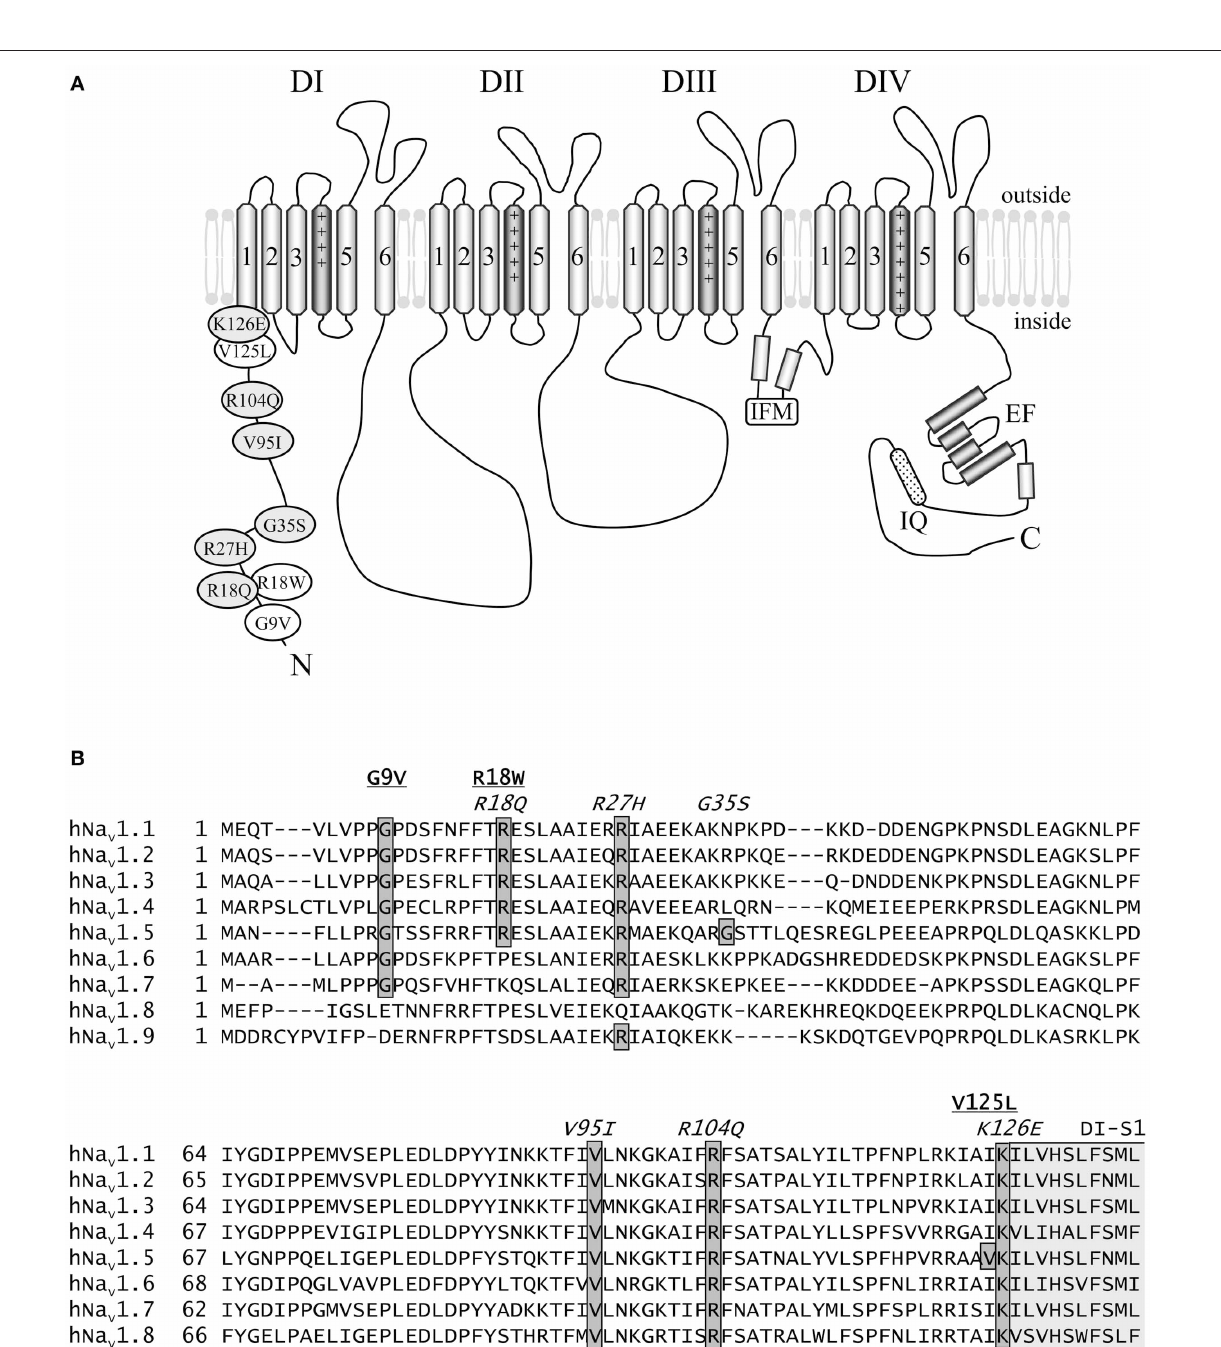
the Na v 1 subfamily. Residues at position 35 are variable, and position 125 is occupied by isoleucine in all other human Na + channels. All eight residues affected by a SCN5A mutation are identical in Na v 1.5 of human, rat, mouse, and dog (not shown). The N-terminal region of the first putative membrane spanning segment DI-S1 is indicated in light grey. References: G9V (Millat et al., 2006), R18W (Tester et al., 2005), R18Q (Kapplinger et al., 2010), R27H (Priori et al., 2002), G35S (Levy-Nissenbaum et al., 2001), V95I (Liang et al., 2006), R104Q (Levy-Nissenbaum et al., 2001), V125L (Tester et al., 2005), K126E (Vatta et al.,